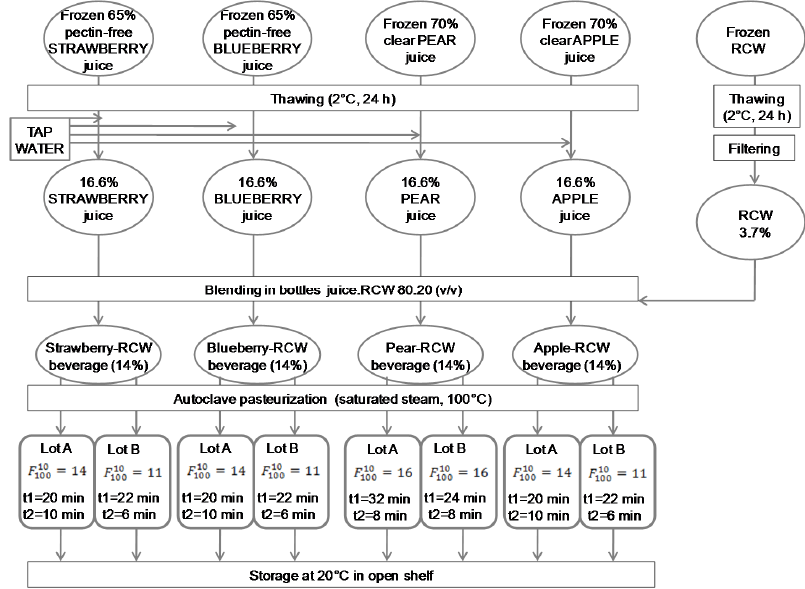
Figure 1. Process flow diagram for the preparation of pear ‐ RCW, apple ‐ RCW, strawberry ‐ RCW, and blueberry ‐ RCW beverages; t1 refers to the time passed to reach the (cid:1832) (cid:2869)(cid:2868)(cid:2868)(cid:2869)(cid:2868) value and t2 refers to the (cid:1832) (cid:2869)(cid:2868)(cid:2868)(cid:2869)(cid:2868) value holding time.